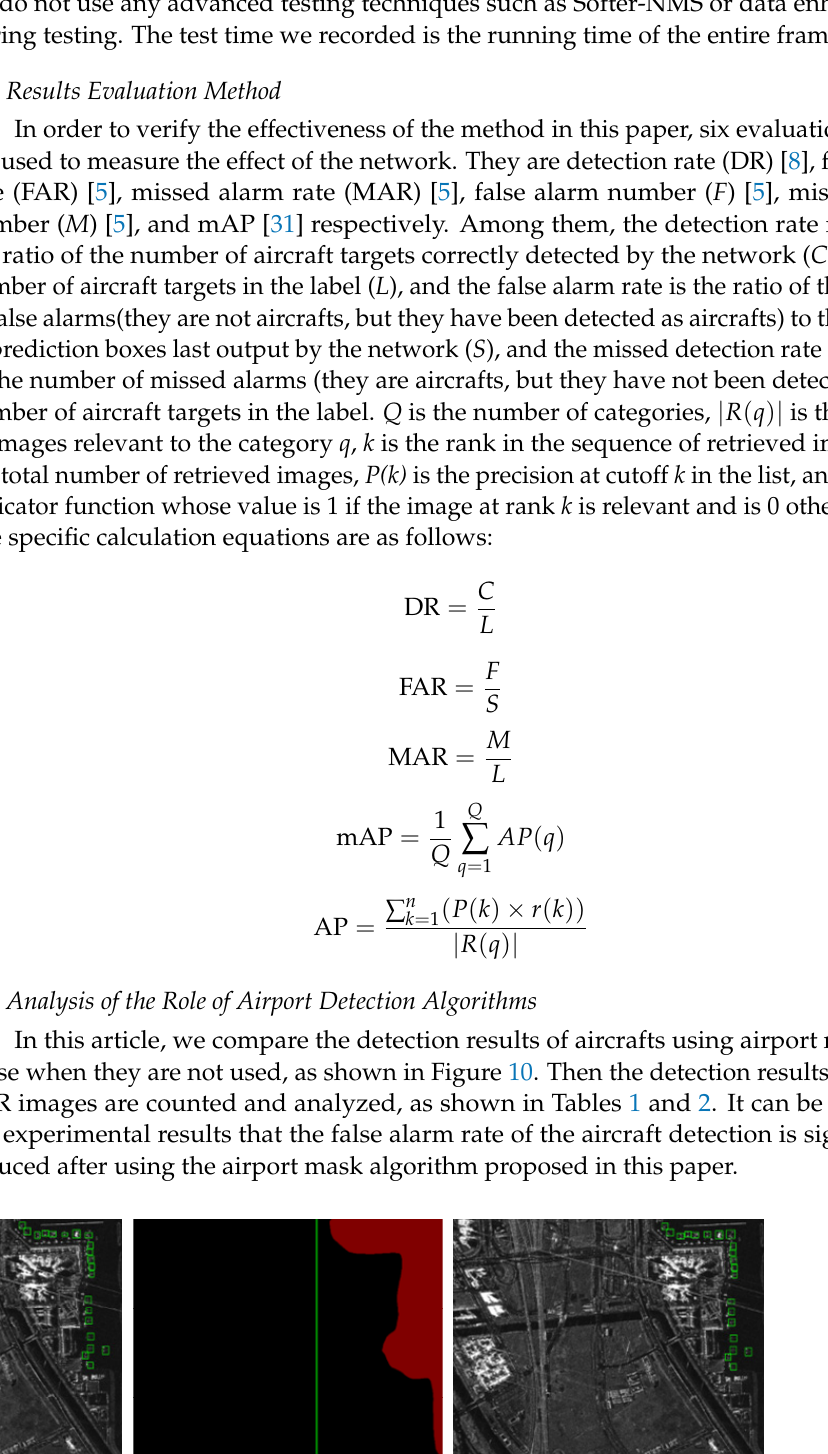
11 Table 2. Comparison of airport detection algorithms e ffectiveness of EWFAN network. Network